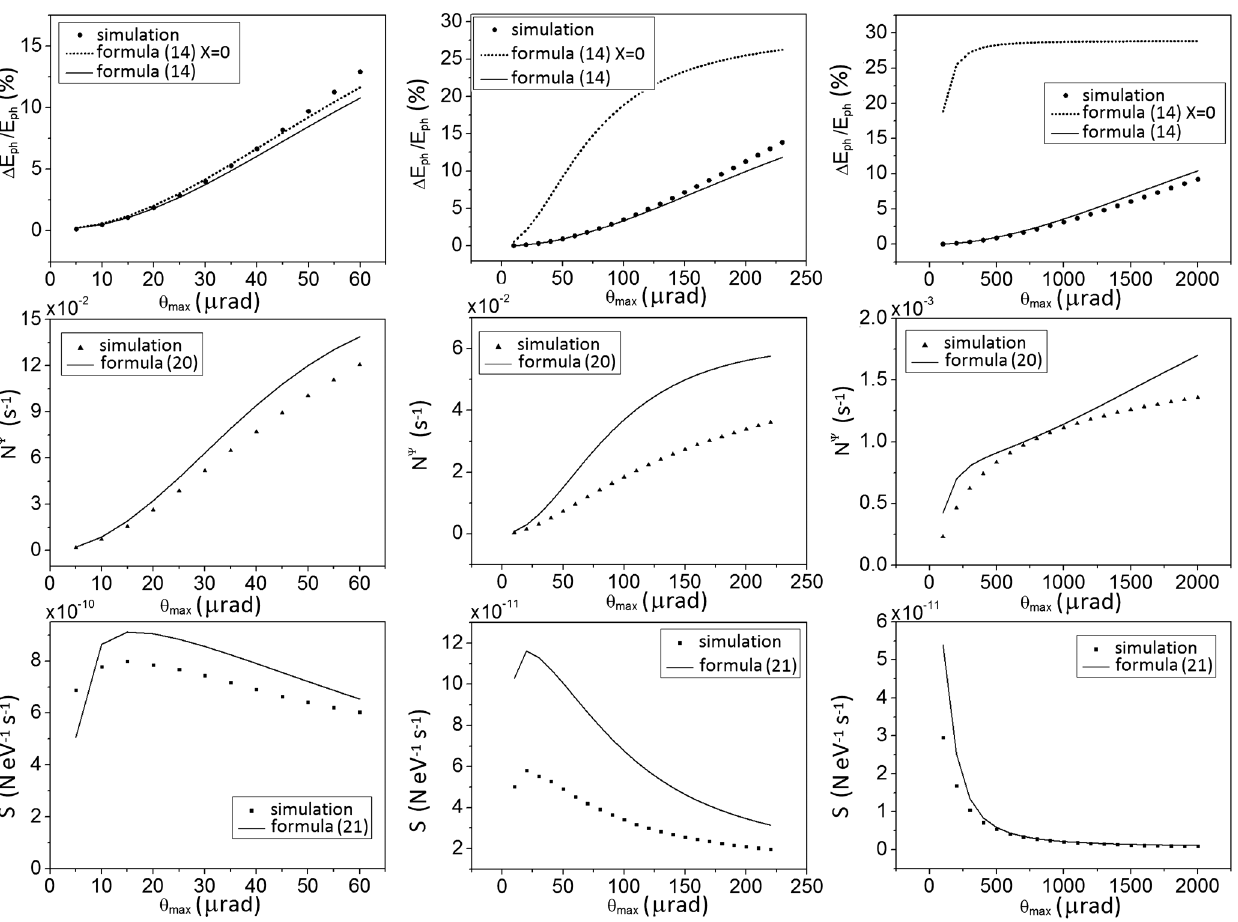
=E FIG. 6. Δ E (%) value from CAIN simulation vs formula (14) without and with X correction. N Ψ (s − 1 ) number of photons in ph ph θ : simulated values vs formula (20). S (N eV − 1 s − 1 ) spectral density per shot ( r ¼ 1 ): simulated values vs formula (21). Case D left max column, case E middle column and case F right